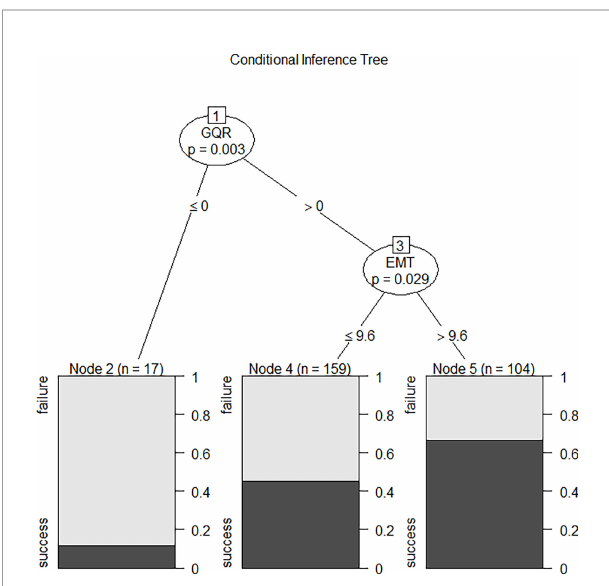
FIGURE 4 | The conditional inference tree screened out two variables to predict the outcome of FET: the fi rst was GQR, and the second was EMT. Among the patients with good-quality embryos, the clinical pregnancy (success) rate of FET was approximately 70% when EMT was thicker than 9.6 mm, but 50% when EMT was no thicker than 9.6 mm. For the patients without good-quality embryo, the clinical pregnancy (success) rate of FET was approximately 10%. EMT, endometrial thickness on the day of progesterone treatment; GQR, good-quality embryo rate; success, success of clinical pregnancy; failure, failure of clinical